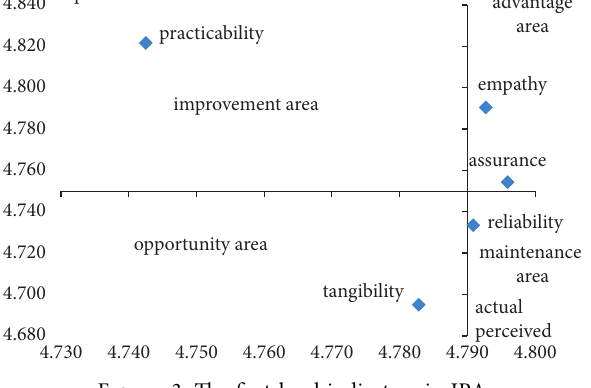
Figure 3: The first-level indicators in